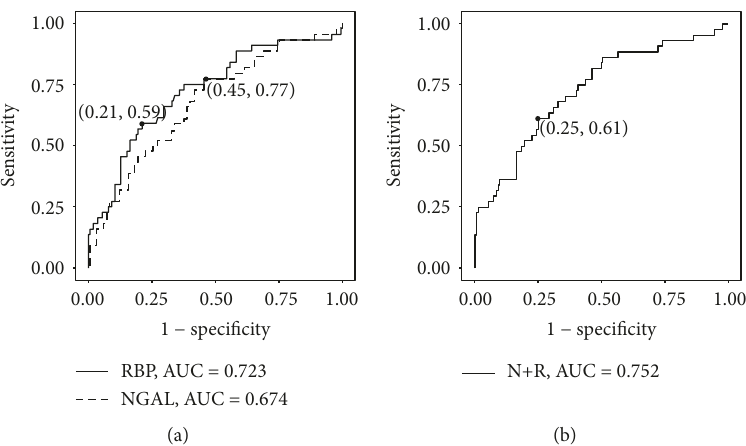
Figure 4: ROC analyses of urinary NGAL and RBP for renal insu ffi ciency in T2DM patients with normoalbuminuria. (a) ROC curve for the ability of NGAL and RBP to identify cases with eGFR < 60 ml/min per 1.73m 2 among patients with normoalbuminuria. (b) ROC curve for the combined detection of urinary NGAL and RBP (N+R) to identify cases with eGFR < 60ml/min per 1.73m 2 among patients with normoalbuminuria. ROC: receiver operating characteristic; AUC: area under the ROC curve; N+R: combined detection of urinary NGAL and RBP. Table 2: Clinical characteristics of the matched